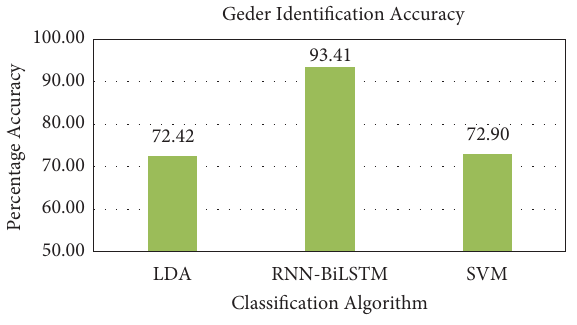
Figure 6: Percentage accuracy comparison for the diferent classifers. Table 5: Comparison of the recall values and identifcation accuracy with reported in the literature. Comparison with reported